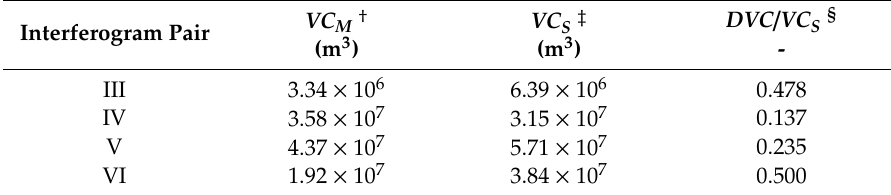
Table 3. Volume changes for the Mogi and Sill sources in the inversion